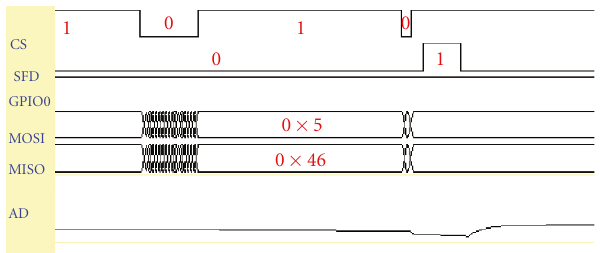
Figure 19: Process of packet sending.